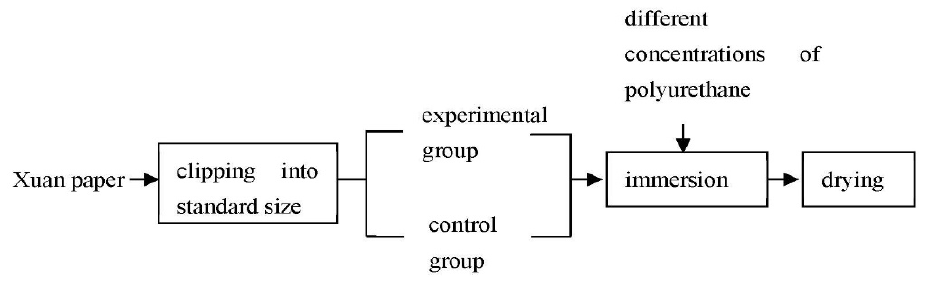
Figure 1. Process of paper